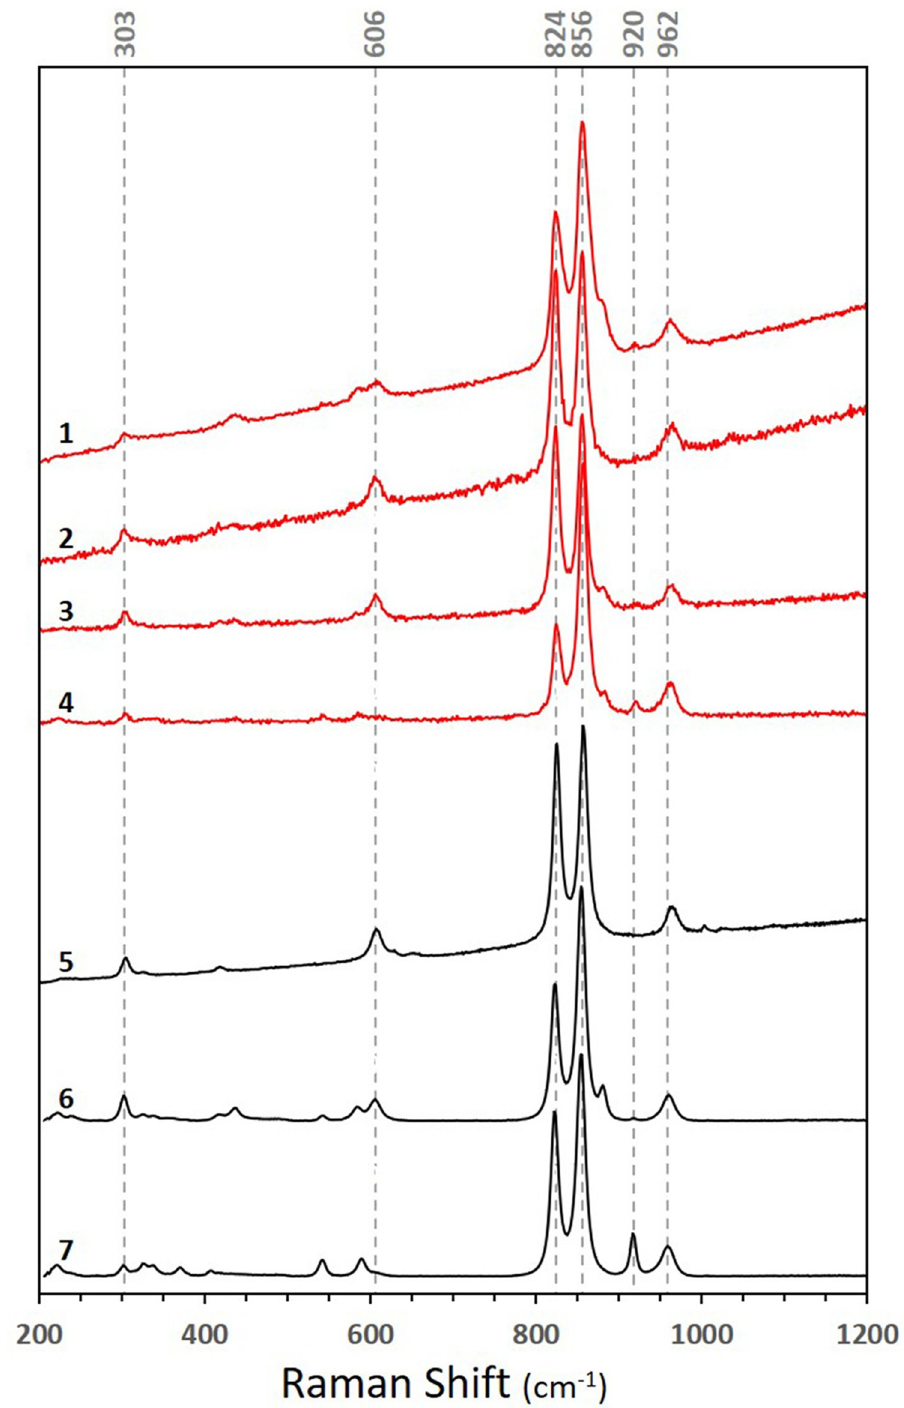
Fig 5. Raman spectra of four representative olivine beads (1–4) placed against three forsterite-rich olivine references. The references were acquired from https://rruff.info/, comprising olivine from San Carlos, Arizona, USA (5; RRUFFID = R040018), Zabargad Island, Egypt (6; RRUFFID = X050085), and East Africa (7; RRUFFID = X050081).